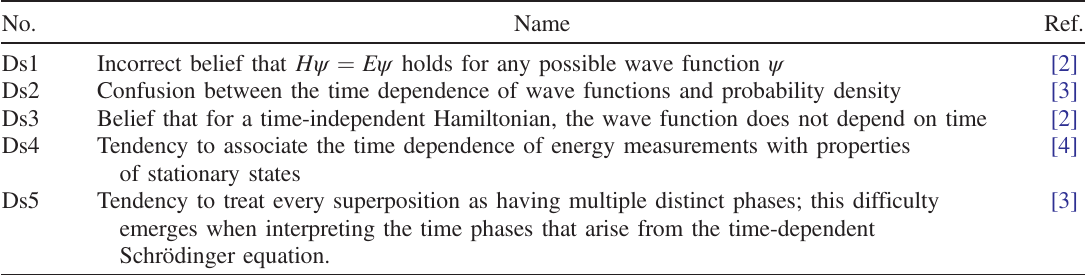
TABLE II. Difficulties that exhibit displacement error in problems that require frame shifting. These difficulties are labeled “ D ” for displacement errors and “ s ” because their problems require shifting. The ordering of the difficulties in the table is for labeling purposes only and does not represent a